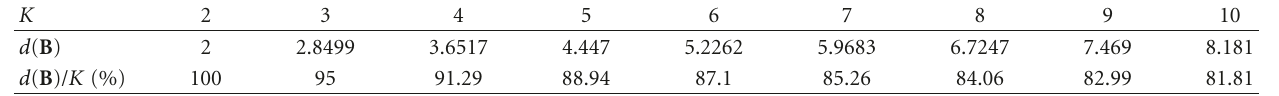
Table 2: Average number of distinct columns in B , d ( B ), for K = 2 to K =